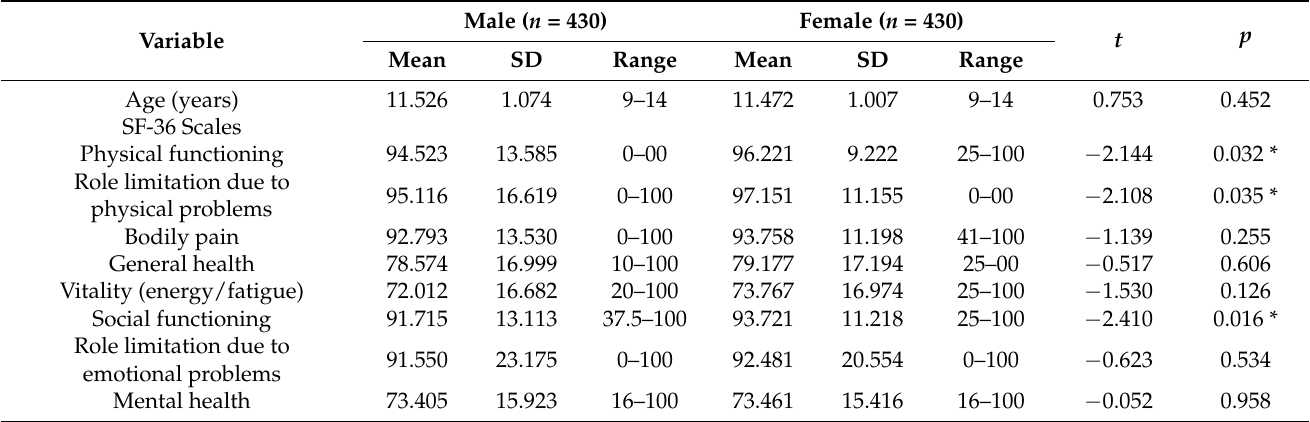
Table 1. Demographic information and descriptive statistics on SF-36